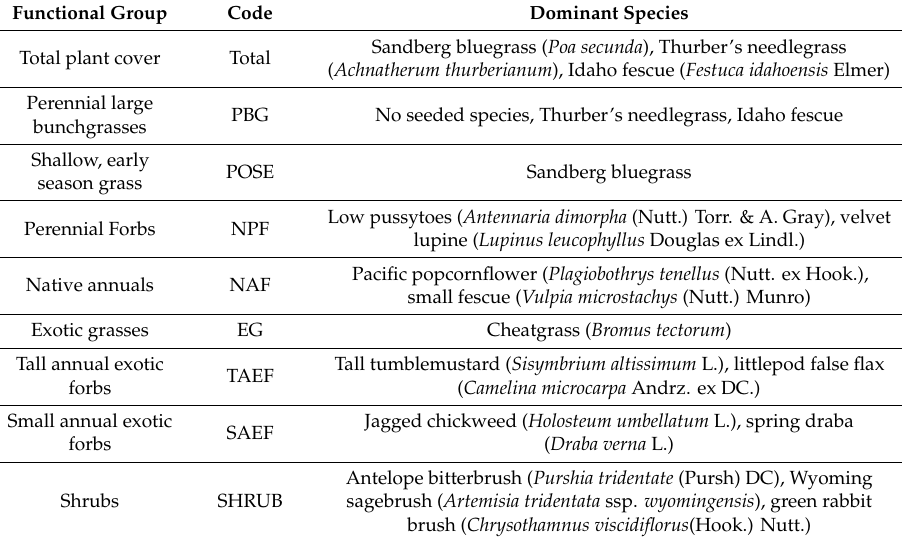
Table 2. Understory plant functional groups used as response variables, the short code used in graphs, and dominant species for each group from undisturbed controls in 2017. Origin is native unless noted in the group name. Seeded species were analyzed separately ( Elymus elymoides (ELEL), ACMI, Psuedoroegneria spicata (PSSP)). The nomenclature follows Meyers et al. [48] for grasses, and Hitchcock and Cronquist [49] for other species.